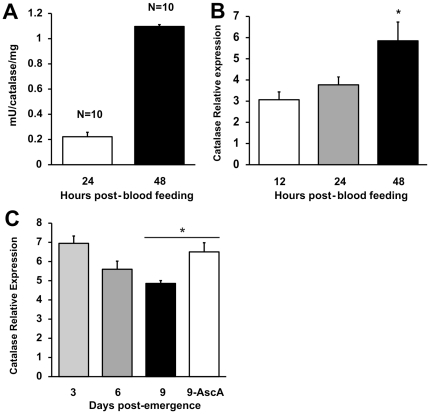
Changes in catalase in the developing oocyte of Lu. longipalpis.(A) Catalase activity of developing oocytes after blood feeding. Six day old female Lu. longipalpis were blood-fed and dissected at 24 and 48 hours. Enzymatic activity in the developing oocytes was significantly higher at 48 hours compared to 24 hours after blood feeding (P<0.0001 , T-test). Bar charts represent mean ± SE of combined samples from 2 independent experiments. (B) Relative expression of catalase LlongKat1 mRNA in developing oocytes dissected at 12, 24 and 48 hours from 6 days-old blood-fed female Lu longipalpis, (n = three groups of 20 females each). Asterisk indicates statistical difference at P<0.05 (ANOVA). Bar charts represent mean ± SEM of combined samples from 2 independent experiments. (C) Age-related decrease of catalase mRNA relative expression in developing oocyte. Flies were blood-fed at 3, 6 and 9 days Post-Emergence (n = three groups of 15 females each) and whole ovaries were dissected 48 hours after blood feeding. Relative expression was statistically different in all 3, 6 and 9 days old flies (P = 0.001, ANOVA). A 4th group (n = 15 females) fed on an ascorbic acid-supplemented sugar solution upon emergence (9-AscA) showed catalase relative expression levels similar to groups of younger flies fed on 70% sucrose solution, and statistically higher than the non-treated, 9 DPE group (P<0.002, t-test). Bar charts represent mean ± SEM of combined samples from 2 independent experiments.